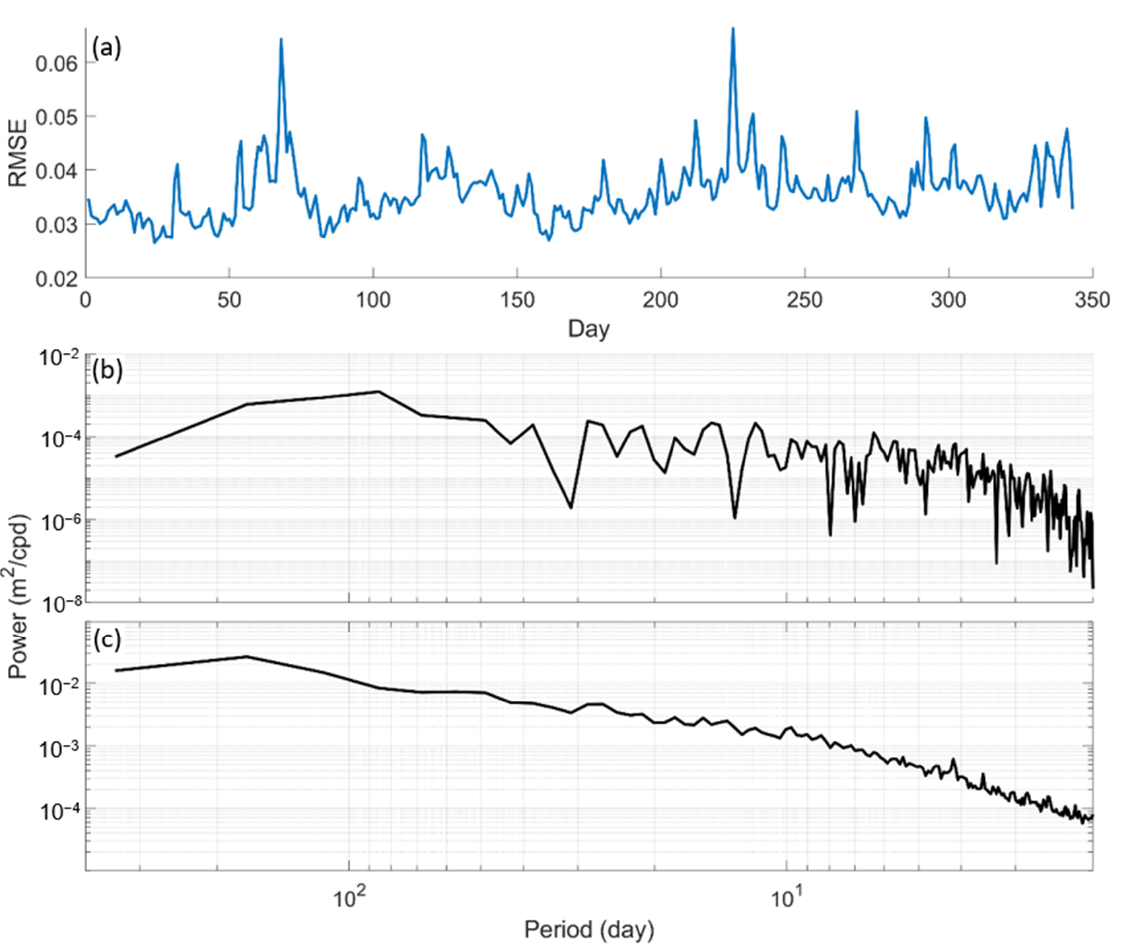
Figure 14. ( a ) Time series of daily averaged RMSE. ( b ) FPSD of daily averaged RMSE. ( c ) Averaged FPSD of errors of each grid.